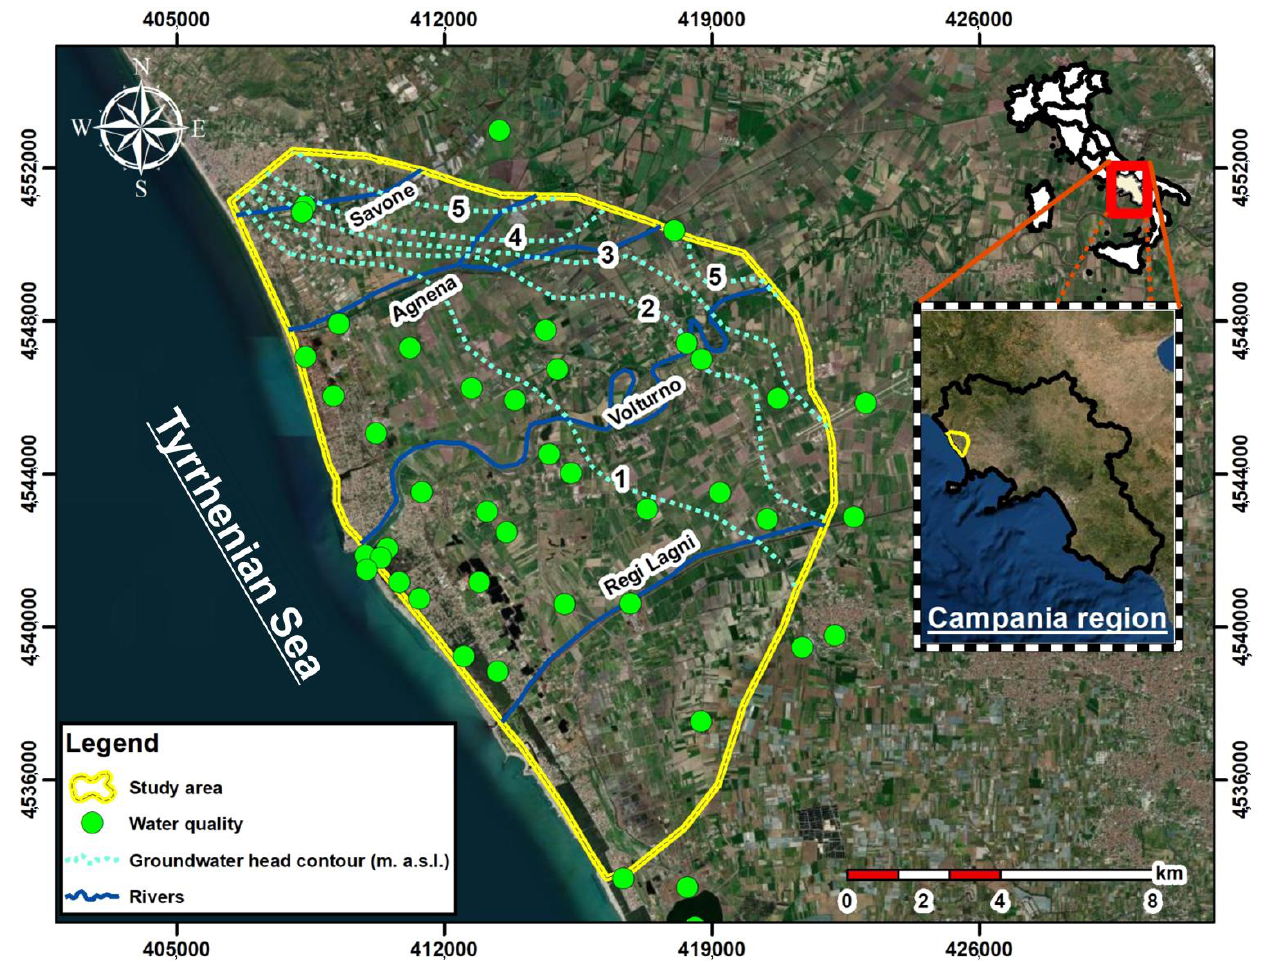
Figure 1. Location map of the study area (yellow boundary), well locations (green dots), main river courses (blue lines) and groundwater head contours (dotted lines).